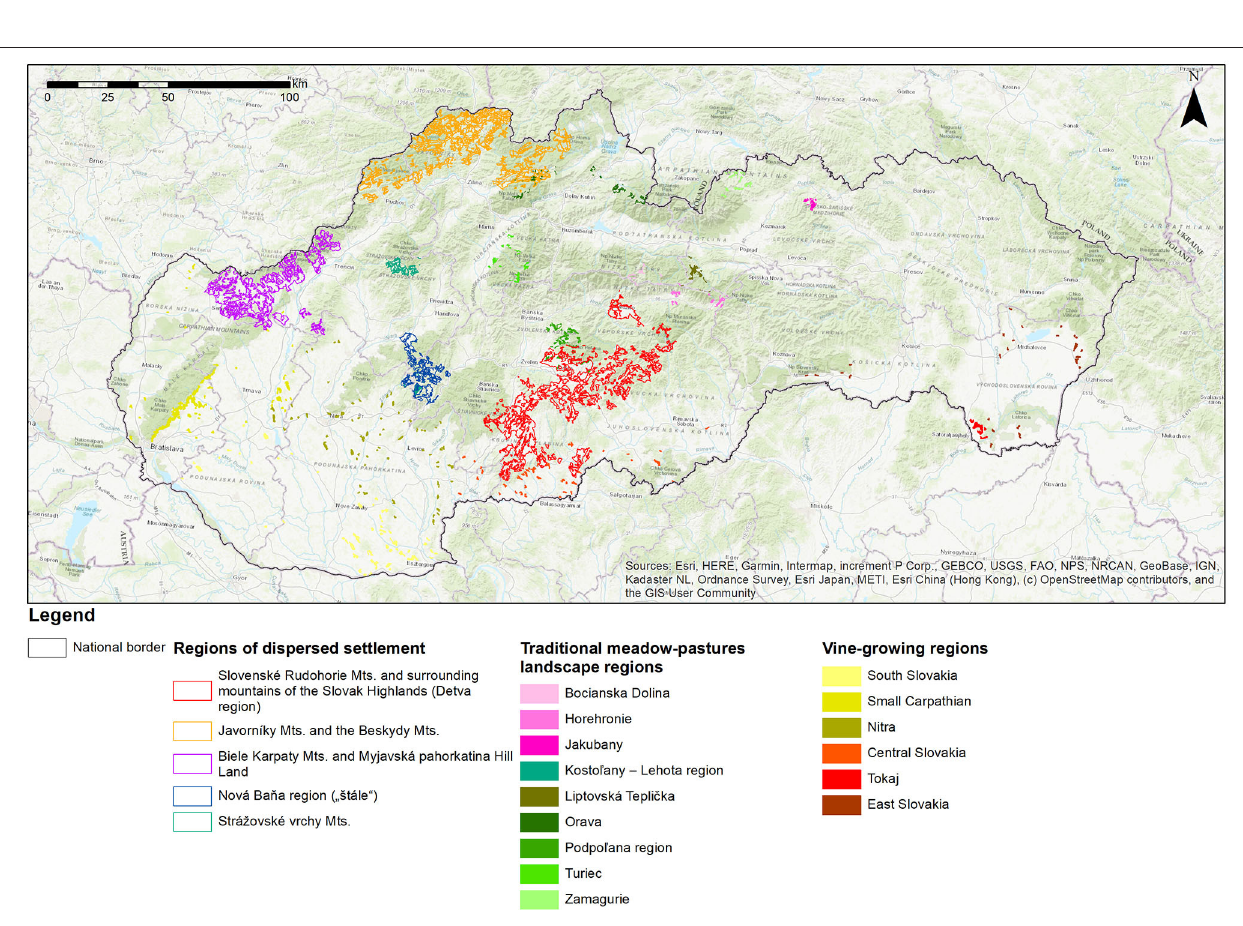
Frontiers in Sustainable Food Systems |